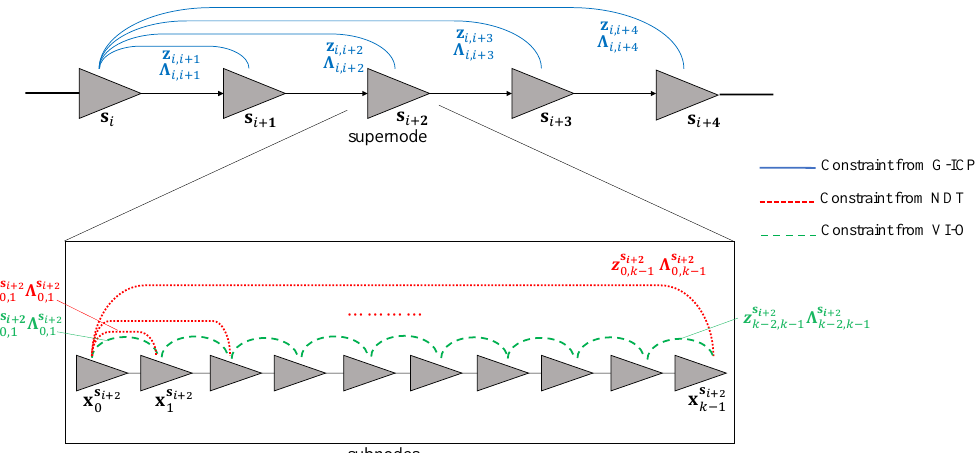
Figure 4. Illustration of the proposed graph structure. The green dashed lines represent the constraints generated through VI- odometry (O)-based pose estimation, and the red dotted line represents the constraint obtained through NDT-based odometry. Thus, each subnode is composed of a state estimate obtained using VI-O and a 3D LiDAR sweep. Note that these two measurements induce local optimization within a set of subnodes to ensure stable node generation. The blue solid lines represent the constraints generated via G-ICP matching, which are used for global